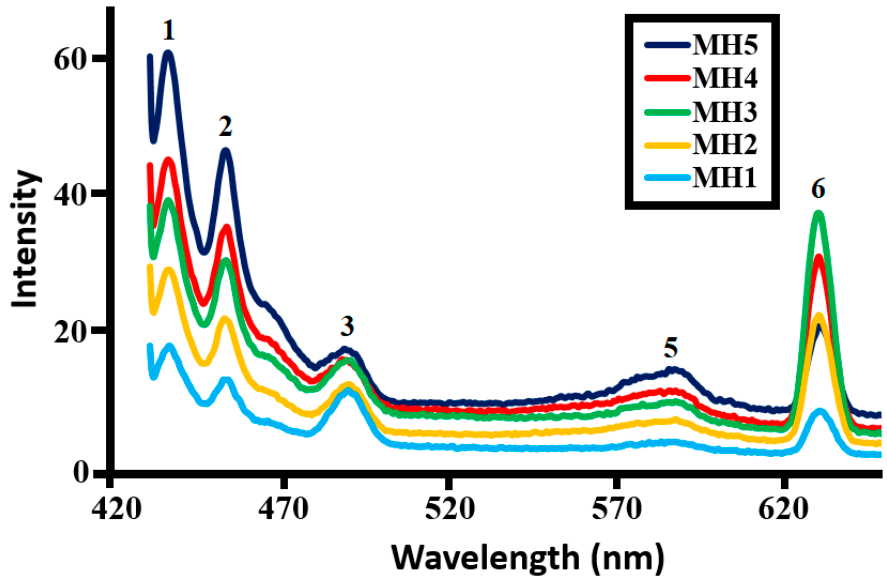
Figure 3. Photoluminescence (PL) spectra of the nanomaterials